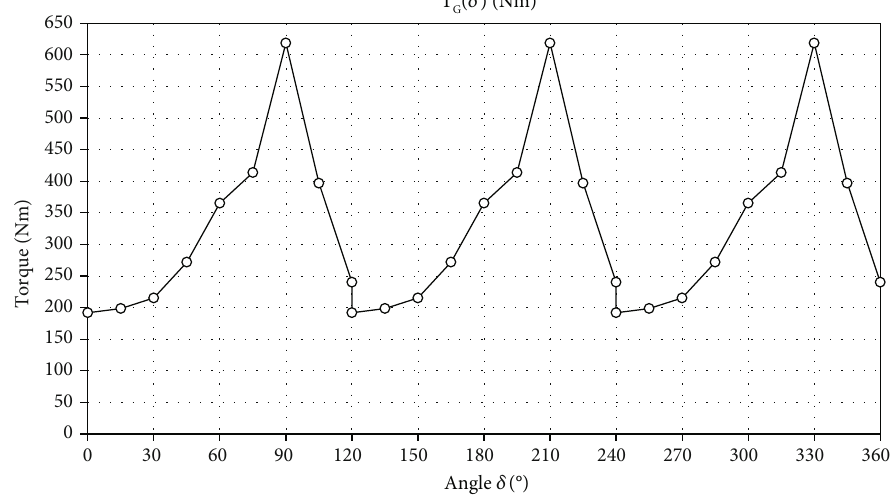
Figure 15: The torque as a function of the angle δ (the gantry